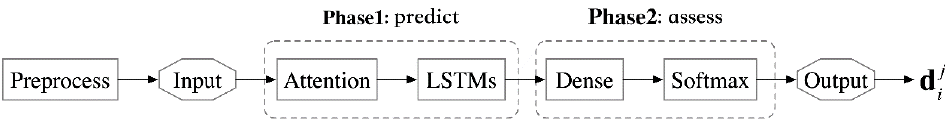
Figure 3. Single-node assessment model based on the collaboration of multiple nodes.